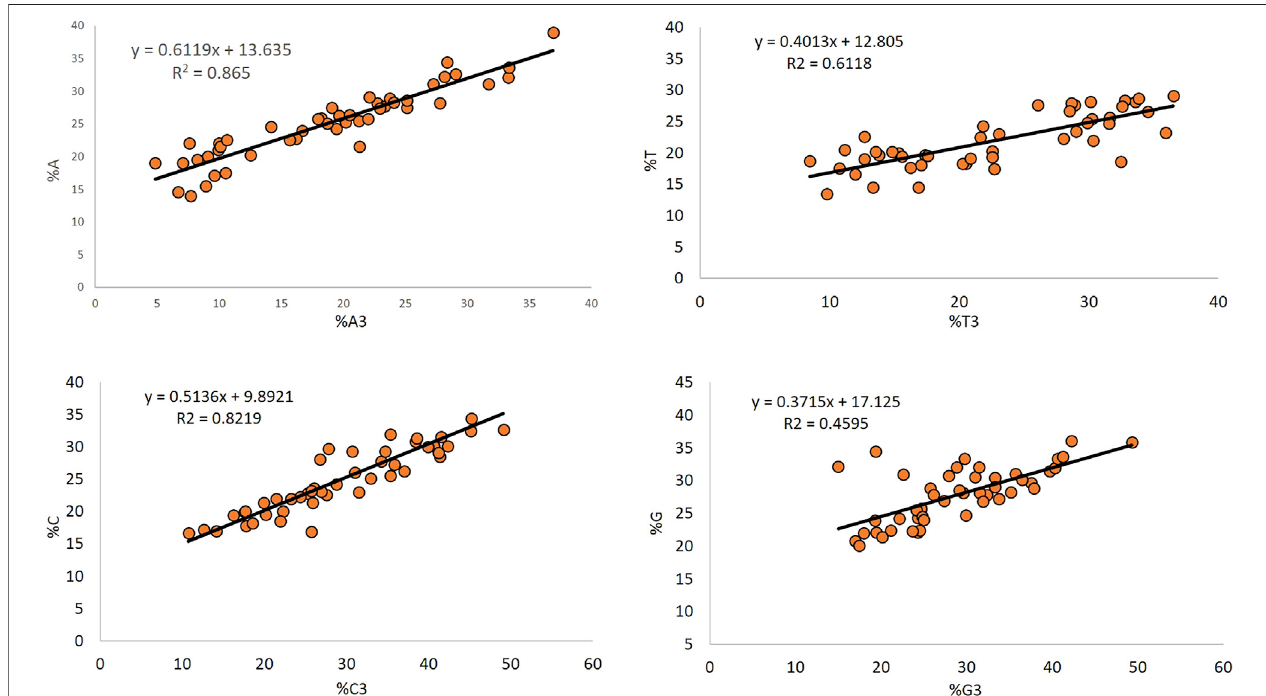
FIGURE 6 | Determination of the effect of mutational force on composition by regression